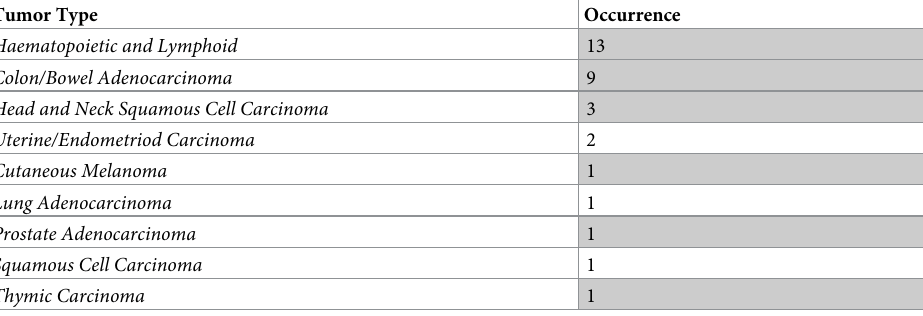
Table 3. Frequency of S146L/S161L mutations in human cancer. Tumor Type